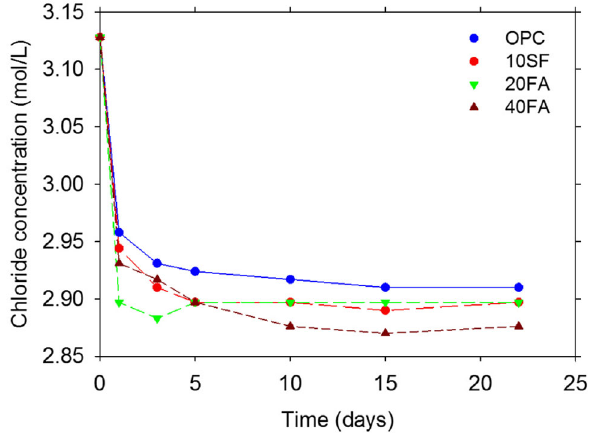
Fig. 4 XRD patterns of the cement pastes after equilibrium testing at 28